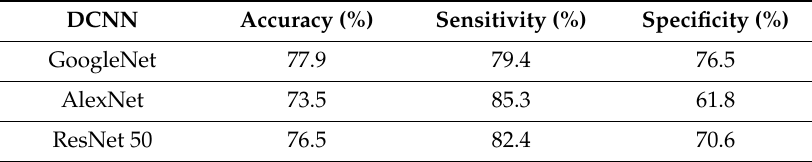
Table 4. Performance metrics of GoogleNet, AlexNet, and ResNet DCNNs.